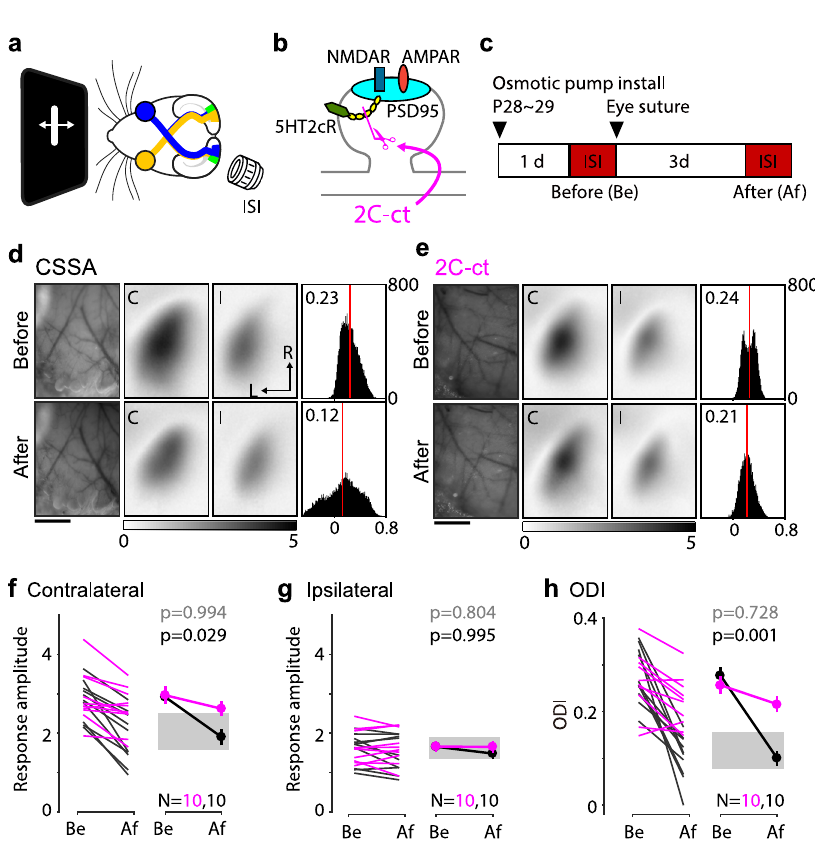
Fig. 5 Blockage of the conversion of the LTD trace impairs the ocular dominance plasticity in juvenile mice. a Schematic of the experiment to record the visual cortical response in the binocular region (green region in left hemisphere) of the V1. b A diagram illustrating that 2C-ct disrupts the direct interaction of the 5HT2c receptor with PSD-95. c Experiment timeline. ISI was performed before (Be) and after (Af) the 3d MD. d , e Representative change of the visual cortical response by the 3d MD in the presence of the control peptide, CSSA ( d ), or 2C-ct ( e ). Left: vasculature pattern of the imaged region used for alignment. Scale bar, 1 mm. Middle: magnitude map of the visual cortical response evoked by contralateral [C] or ipsilateral [I] eye from the recorded hemisphere. Gray scale (bottom): response amplitude as the fractional change in re fl ection x10 4 . Arrows: L, lateral, R, rostral. Right: histogram of the ODI illustrated in the number of pixels (x-axis: ODI, y-axis: number of pixels). Red line indicates the average. f – h Summary of the changes in response amplitude evoked by the contralateral ( f ) and ipsilateral ( g ) eye as well as the change of ODI ( h ) before (Be) and after (Af) the conditioning. Left: individual experiments in the presence of CSSA (black) or 2C-ct (purple); Right: average ± s.e.m. of the left plot. p -values: Two-way ANOVA and post hoc Sidak ’ s multiple comparisons test between the 2C-ct group and the CSSA group at before (gray) and after(black) the 3d MD. Gray region indicates a 95% con fi dential interval of 3d MD mice without peptide infusion. Source data are provided as a Source Data fi le.